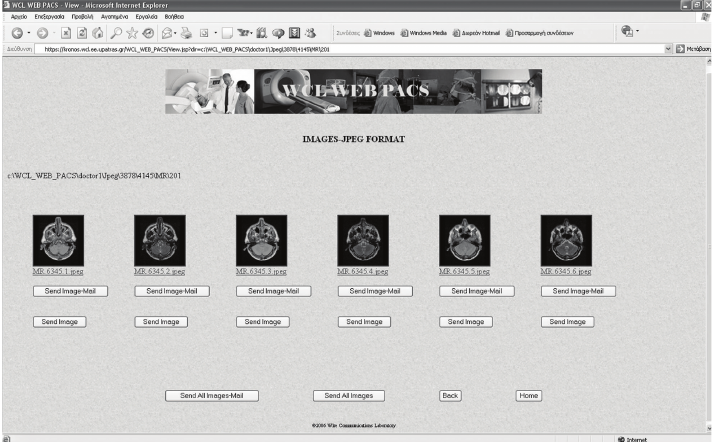
Figure 5: User interface of the Common View service—Thumbnails of images belonging to a